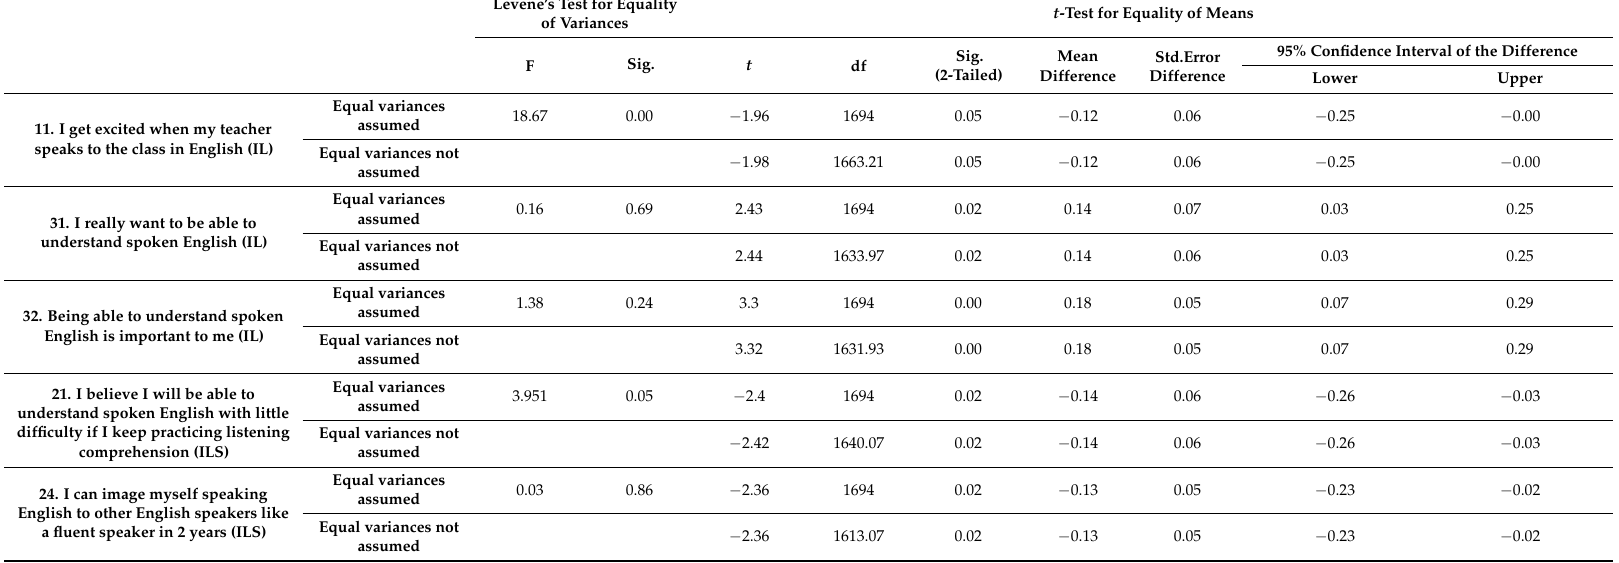
Table 2. Interest in the L2 (IL) and ideal L2 self (ILS) items pre- and post-test. Levene’s Test for Equality of Variances t -Test for Equality of